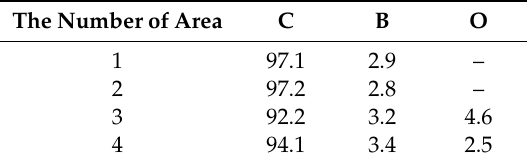
Figure 6. SEM image of Sample 1 with areas for identifying surface composition. Table 3. Sample 1 elemental